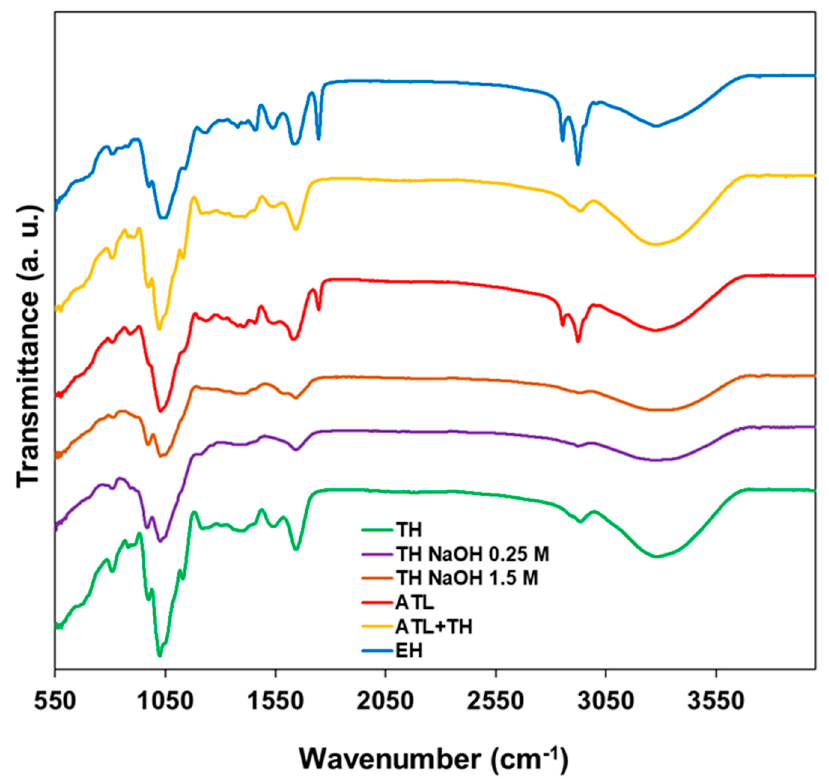
Figure 1. ATR-FT-IR spectra of the mannans extracts correspondent to the following extraction methods: pH-neutral Thermal Hydrolysis (TH); alkaline Thermal Hydrolysis (TH NaOH 0.25 M and TH NaOH 1.5 M); Autolysis (ATL); Autolysis followed by pH neutral Thermal Hydrolysis (ATL + TH); and Enzymatic Hydrolysis (EH).